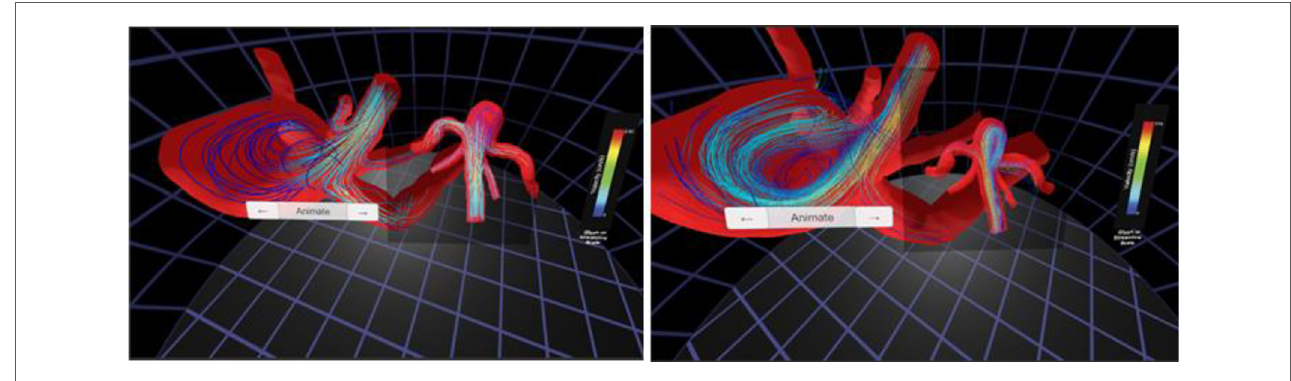
FIGURE 6 Screenshots from immersive viewing of cerebral vascular data with application to characterization of aneurysmal hemodynamics using the Oculus Rift. Streamlines of velocity from CFD simulation results (left) are shown alongside those from 4D fl ow (right). The current viewing location within the geometry and legends for velocity are also present in each panel